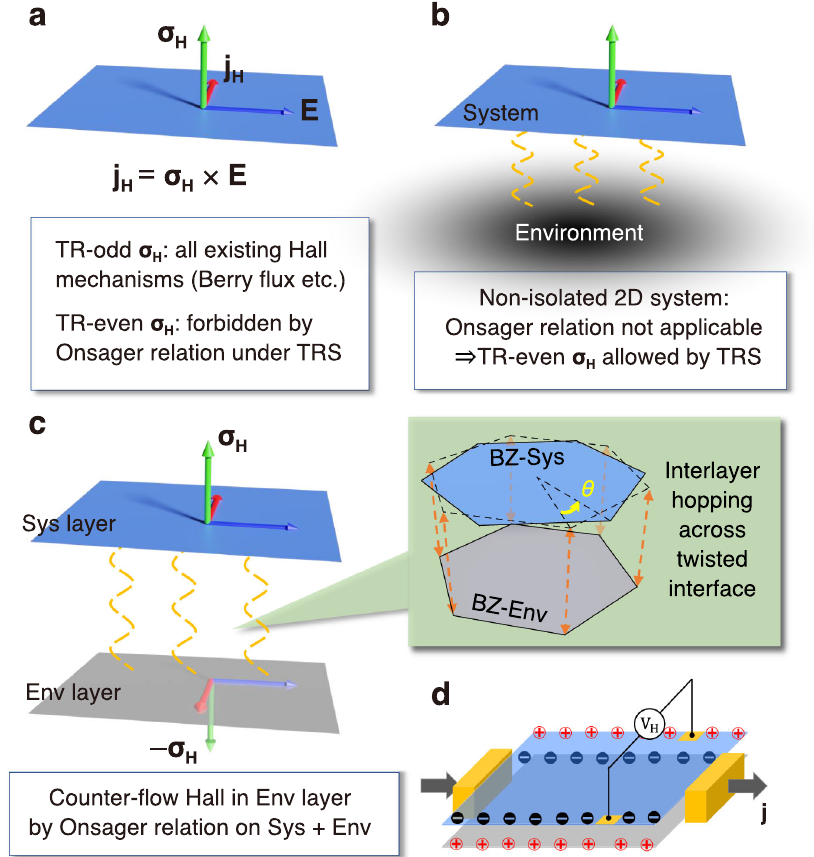
Fig. 1 | Linear charge Hall effect under time reversal (TR) symmetry in a non- isolatedsystem.a IntheHallconductivity σ H ,theTRoddpartbyde fi nitionrequires TR symmetry breaking, while the TR even part vanishes by Onsager relation. The red, green,andbluearrowsdenotethethreevectorsin j H = σ H × E . b ConstraintbyOnsager relation can be lifted in a non-isolated 2D system (blue surface) by coupling to an environment(blackshading). c TR-evenHallcurrentfromtwistedinterfacialcoupling